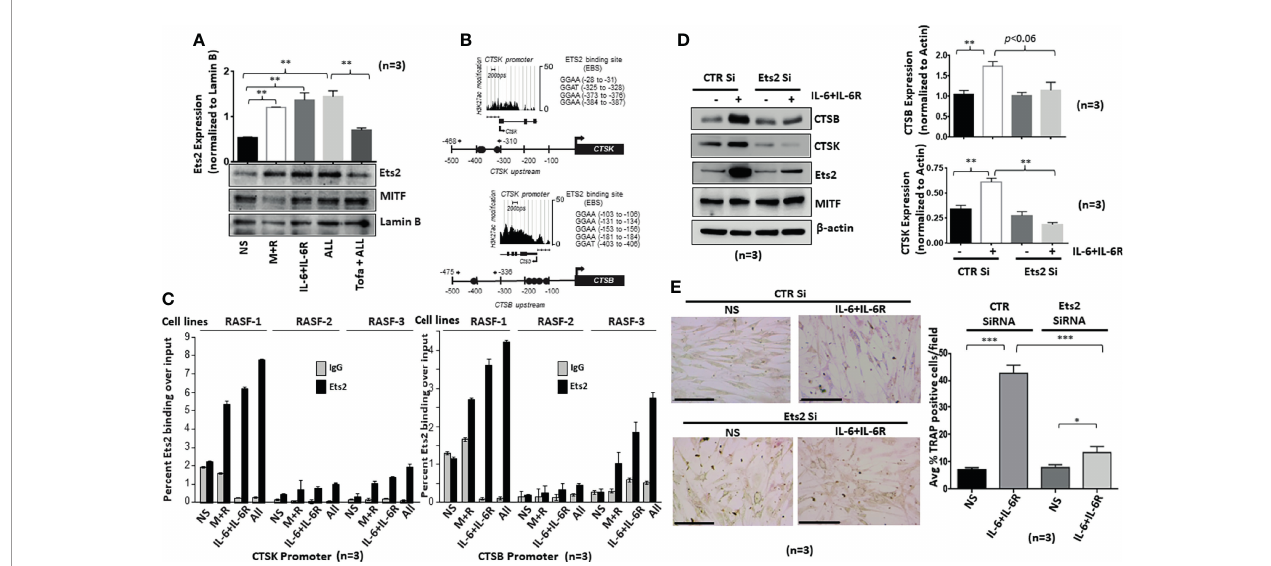
FIGURE 5 | IL-6/IL-6R-induced nuclear translocation of Ets2 and binds to the promoters of CTSK and CTSB genes to promote osteoclastogenesis in RASFs. (A) Ets2 translocates to the nucleus of RASFs within 4 h of IL-6+IL-6R stimulation alone or in combination with M-CSF+RANKL, which was inhibited by tofacitinib. (B) Bioinformatic and ChIP-seq analysis on tracks generated by GSE31621 identi fi ed the core-binding motif (GGAA/T) for Ets2 and the transcriptionally active regions in the promoters of CTSK and CTSB genes. (C) Chromatin immunoprecipitation using anti-Ets2 antibodies enriched CTSK and CTSB promoters from three independent human RASF donor cells upon stimulation with IL-6+IL-6R and M+R+IL-6+IL-6R (All). (D) Ets2 knockdown along with control (CTR), using siRNA, in RASFs treated with IL-6+IL-6R for 12 days resulted in the downregulation of endogenous CTSB and CTSK expression. Bar scale for images acquired is 150 µm. (E) Knockdown of Ets2 in RASFs obliterated the IL-6+IL-6R-induced TRAP-positive staining. *p < 0.05, **p < 0.05-p < 0.01, and ***p <